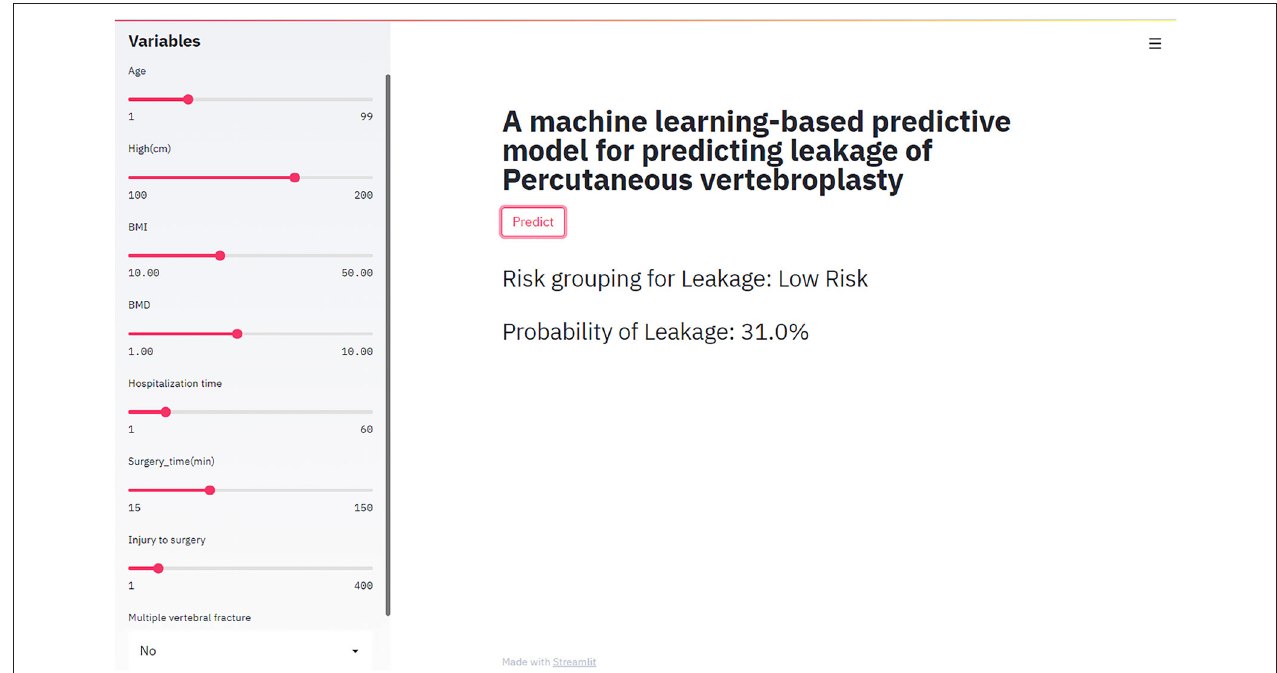
FIGURE 4 | The web-based calculator for predicting bone cement leakage in patients with percutaneous